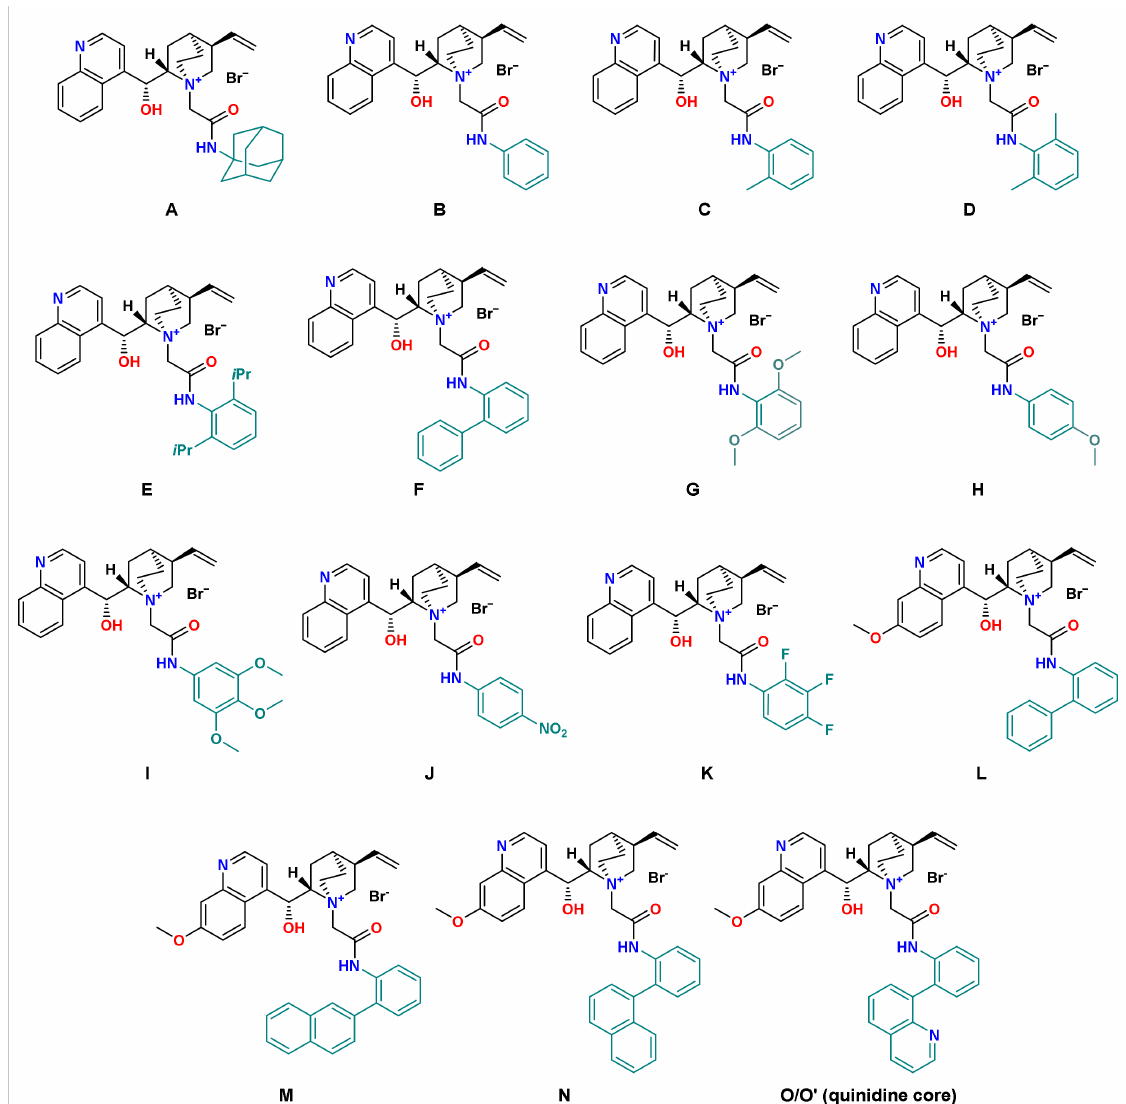
Figure 1. Cinchona phase-transfer catalysts A – O